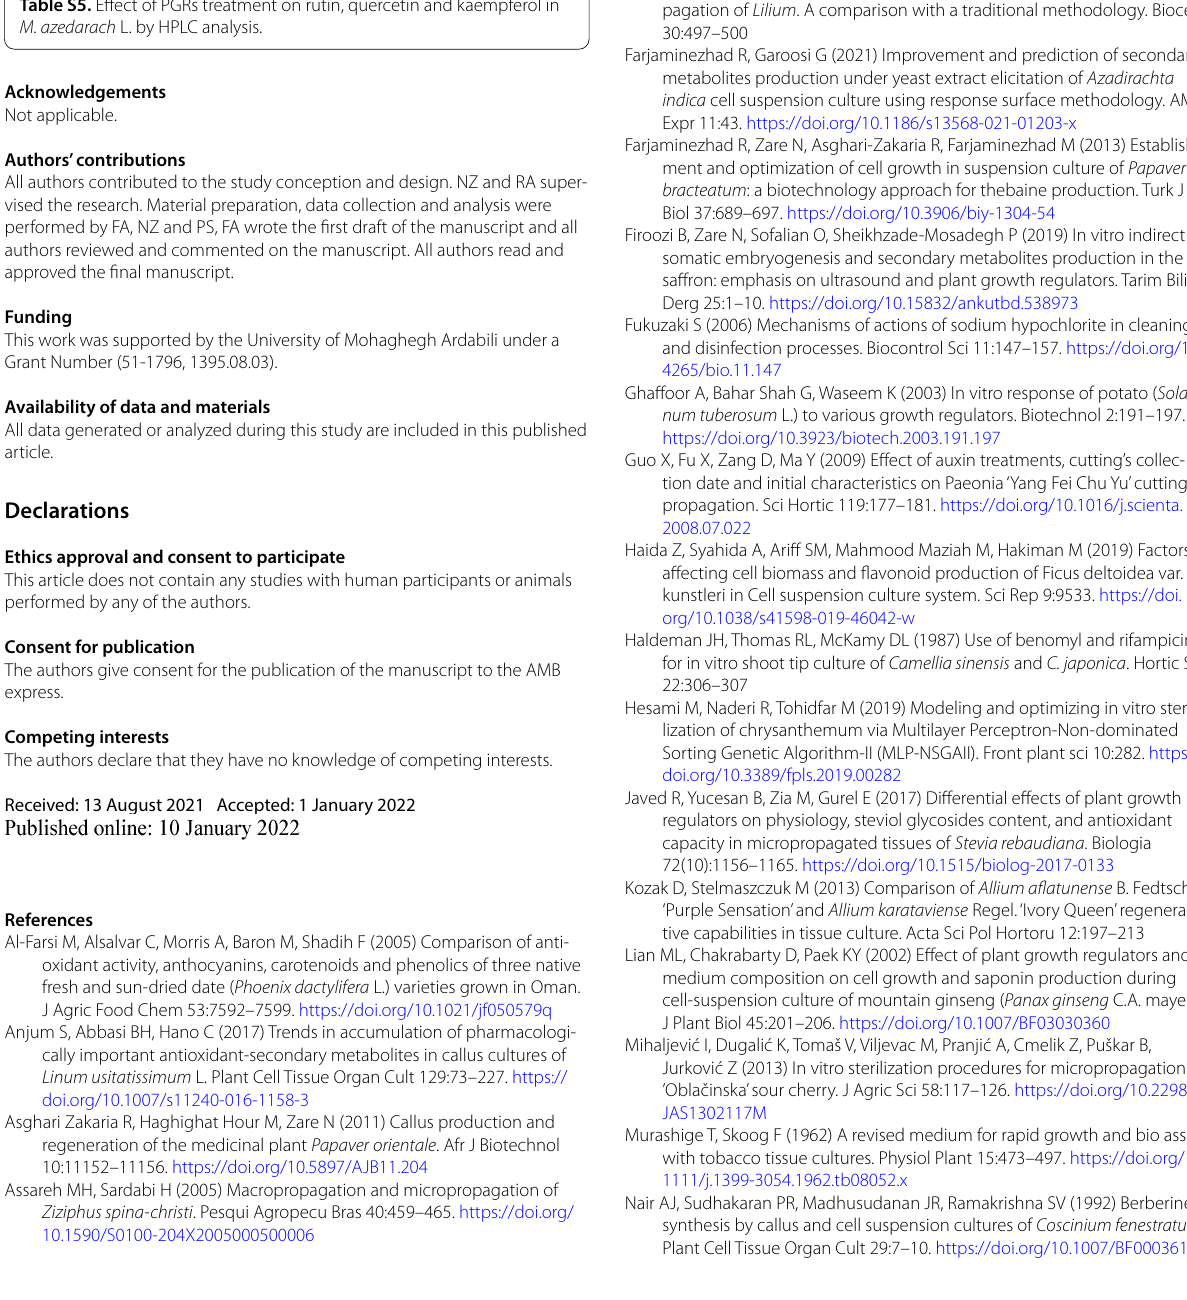
Table S5. Effect of PGRs treatment on rutin, quercetin and kaempferol in M. azedarach L. by HPLC